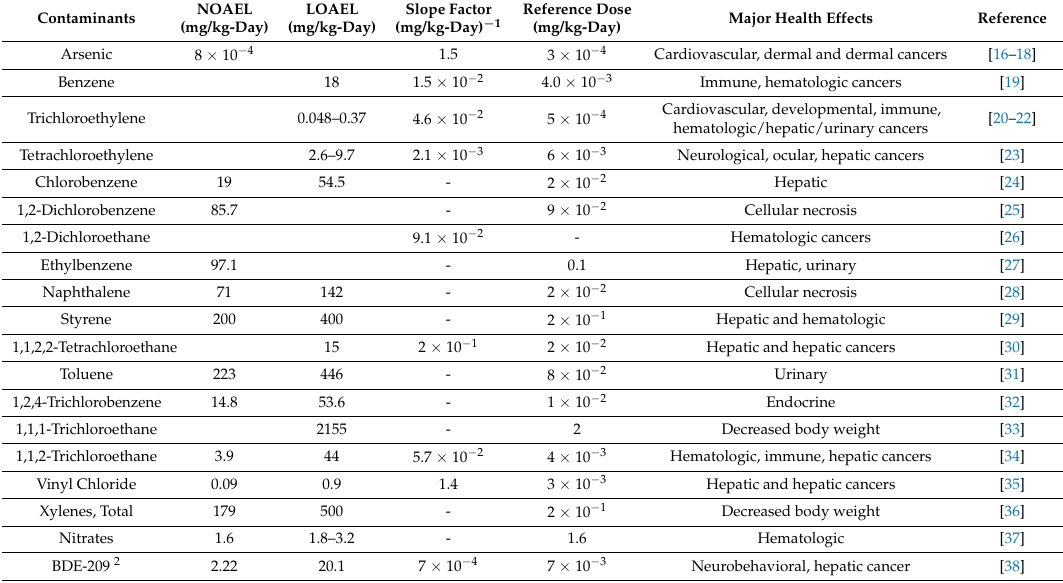
Table 1. Contaminant threshold values and health impacts 1